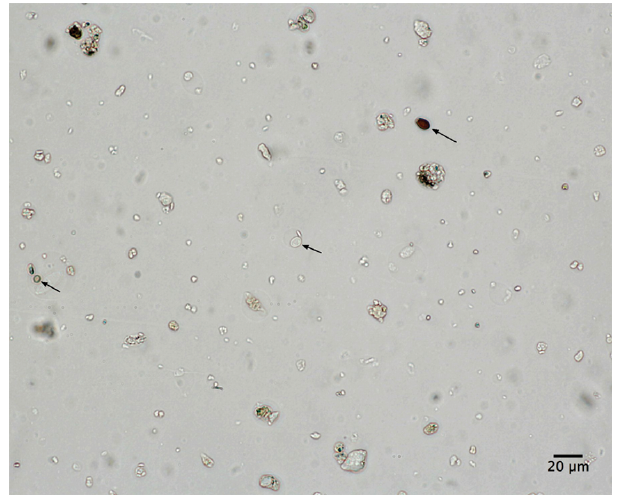
Figure 8. Bright-field microscope image of coarse particles and pri- mary biological particles collected in the air sampler at ATTO at 80m on 2 April 2015. The arrows point to three fungi: the one on the right is a coprinoid spore, in the center is a yeast-like conidia, and on the left is a small fungal spore of unknown